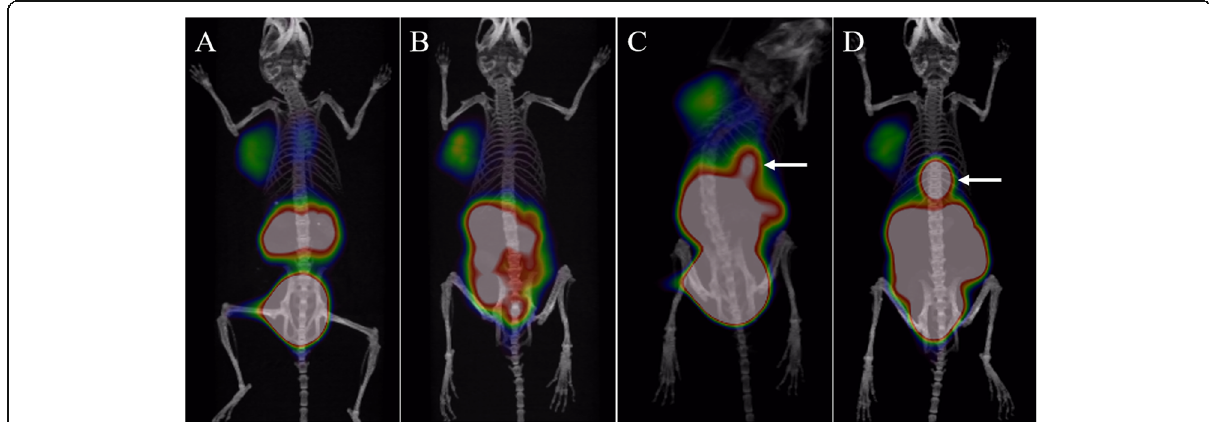
Fig. 4 68 Ga-DOTA-TATE 3D micro-PET/CT imaging at 30 min ( a , SUVmax = 2.87) and 120 min ( b , SUVmax = 1.83) in nude mice bearing AR42J tumours. 68 Ga-NOTA-TATE 3D micro-PET/CT imaging at 30 min ( c , SUVmax = 3.02) and 120 min ( d , SUVmax = 1.64) in nude mice bearing AR42J tumours. Compared with 68 Ga-DOTA-TATE, 68 Ga-NOTA-TATE imaging showed intense radioactivity in the gallbladder (arrow)